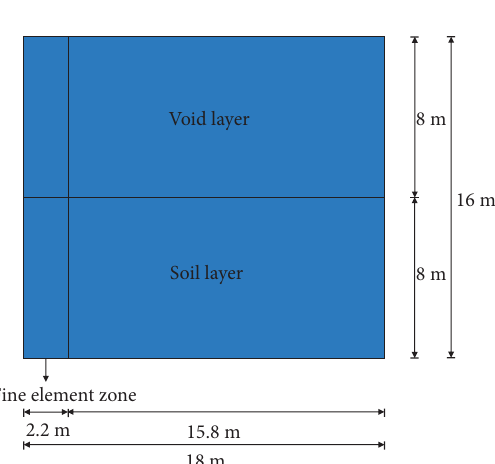
Figure 6: Front view of the soil